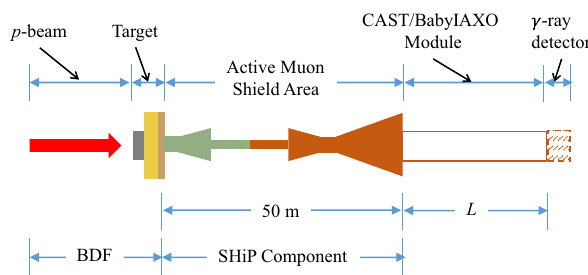
Fig. 2 Conceptual design of PASSAT with the CAST or BabyIAXO magnets. The components from the proton beam through the active muon shield area are from the BDF-SHiP complex proposed at CERN. The X-ray-sensitive detector of CAST/BabyIAXO is replaced by a γ - raydetector.Someadditionalvetodetectorsforbackgroundsuppression may be needed as